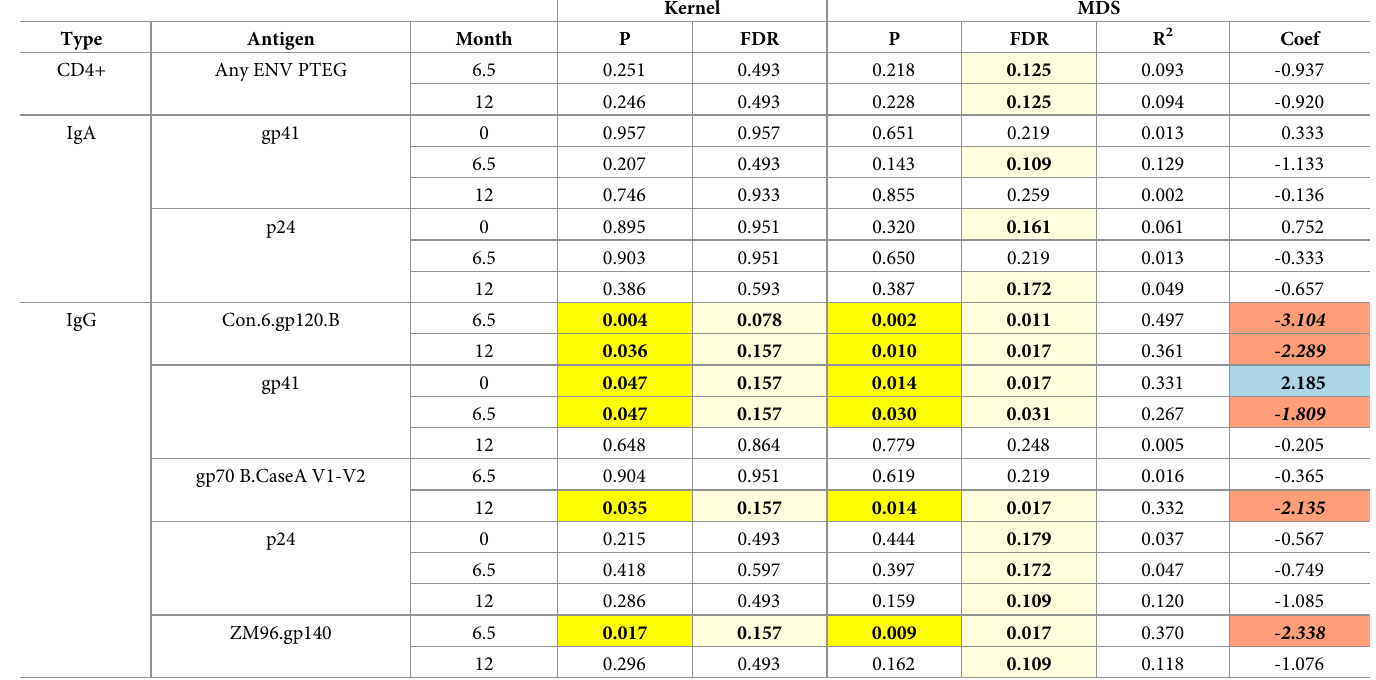
Table 1. Significance values of kernel regression tests, and McFadden’s R2 values, slope coefficients and significance values of logistic regression models show that magnitude of response for several IgG antibodies solicited by vaccines appear to relate to the structure of the microbiota. In these tests, antibody levels were treated as binary, median split variables. Kernel regression asked whether participants that both have high or low concentrations of the antibody or T cell pool of interest have sim- ilar microbiota (as measured by weighted UniFrac) than participants with dissimilar concentrations of that variable of interest. Logistic regression GLMs ask whether the weighted UniFrac axis 1 (MDS1) scores (Fig 1) of the participants are statistically related the variables of interest. The logistic regression GLM coefficients tell us of the direction and strength of the association. R22 indicates Nagelkerke pseudo R2, p-values are calculated by permutation (Kernel regression) and directly (weighted Unifrac Regression), and Benjamini and Holchberg FDR values [27] are calculated using the bioconductor q-value package [29]. Bold text and yellow shading indicate statistically significant p ( < 0.05) and FDR ( < 0.20) values. Regression coefficients corresponding kernel p < 0.05 and FDR < 0.2, values are color-coded according to their sign; blue = positive, red =